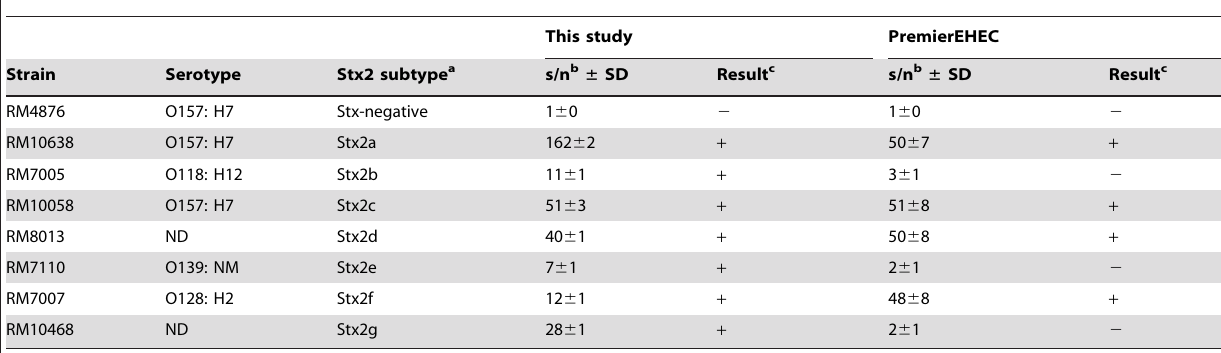
This study PremierEHEC